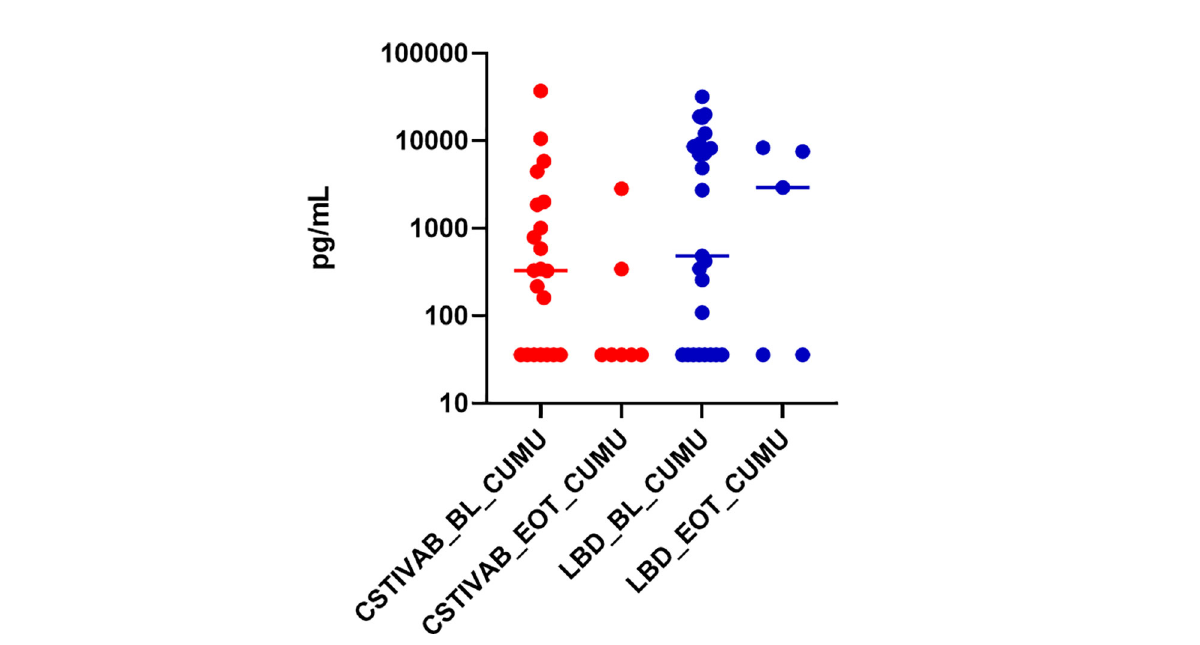
FIGURE 5 | Cumulative (CUMU) p24 antigen production from cervicovaginal (CV) tissue biopsies obtained from all participants at baseline and from participants using the placebo IVR (BL). CUMU p24 antigen production from CV tissue biopsies obtained from participants using the TFV/LNG IVR at end of treatment (EOT). Red dots represent participant data from individuals with diverse anaerobic CST IVA/B microbiota at sampling. Blue dots represent participant data from individuals with Lactobacillus-dominated (LbD) microbiota at sampling. p values > 0.05 for change in p24 antigen production from tissues at EOT compared to